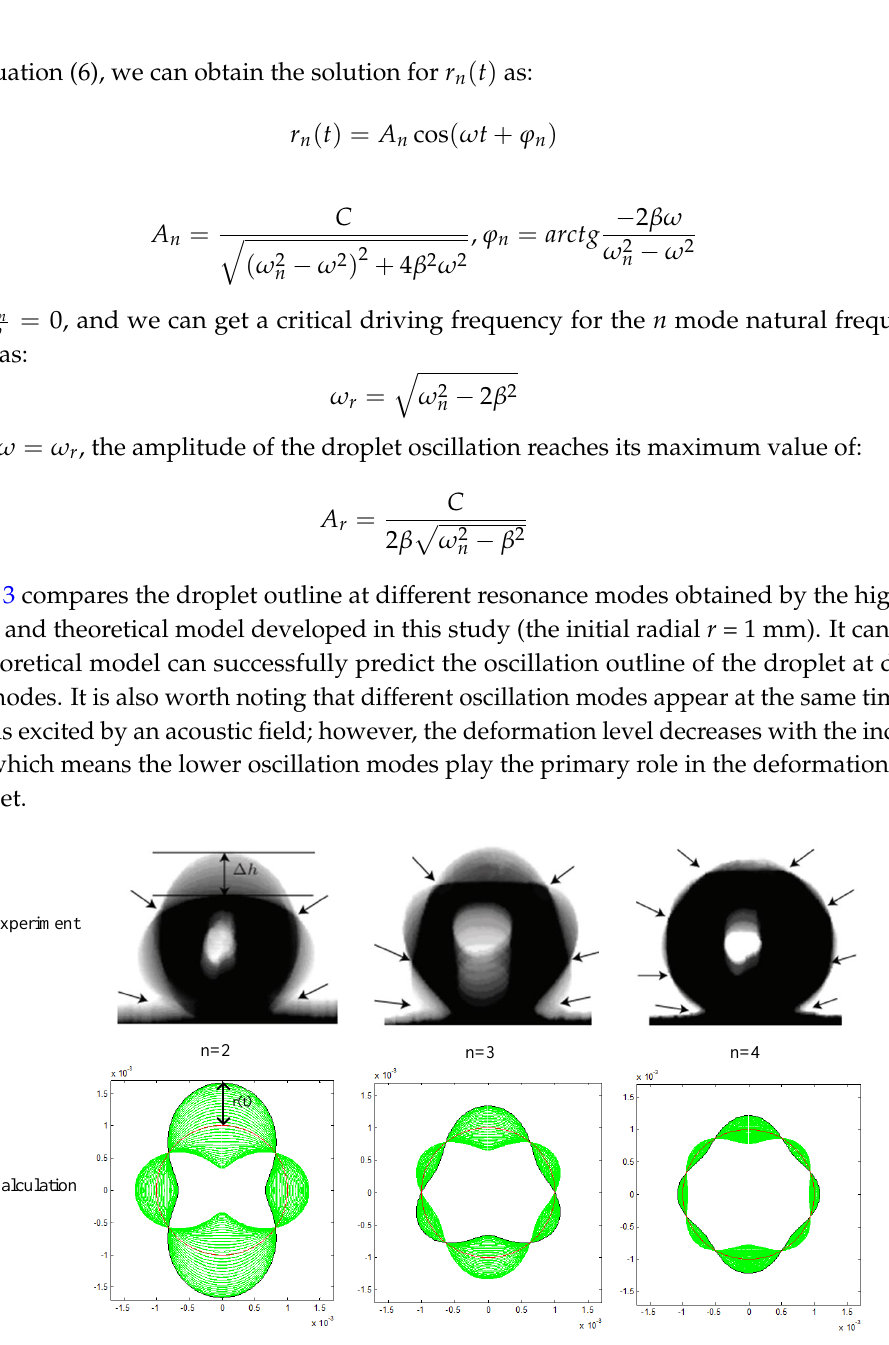
Figure 3. Comparison of droplet outline between experiment [29] and calculation at different resonance modes ( n = 2, 3, 4).